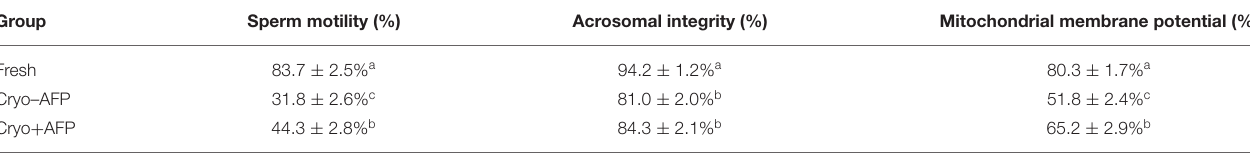
TABLE 1 | The motility, acrosomal integrity, and mitochondrial membrane potential of fresh sperm and post-thaw sperm cryopreserved with or without AFP III ( n = 6).